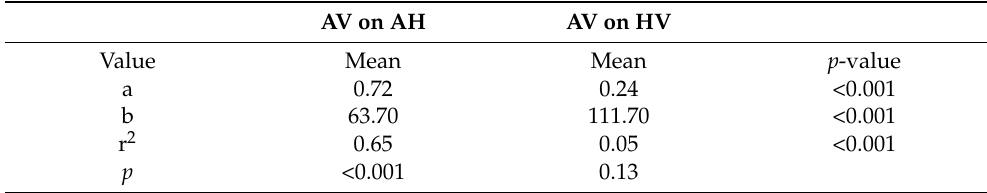
Table 4. Comparison of dependencies of the AV interval on AH and HV intervals for the whole study group.